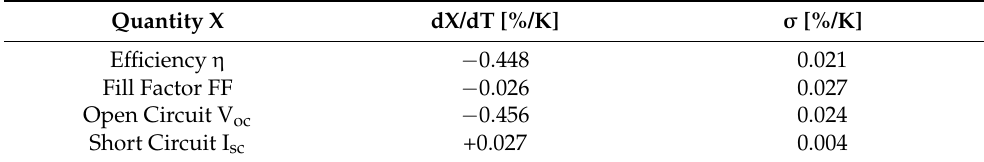
Table 4. Arithmetic means of the normalized temperature coefficients dX/dT for different quantities: power conversion efficiency η , fill factor FF, open circuit voltage V oc and short circuit current I sc ; six PTS submodules were investigated; normalization refers to the quantities at 20 ◦ C; standard deviation σ